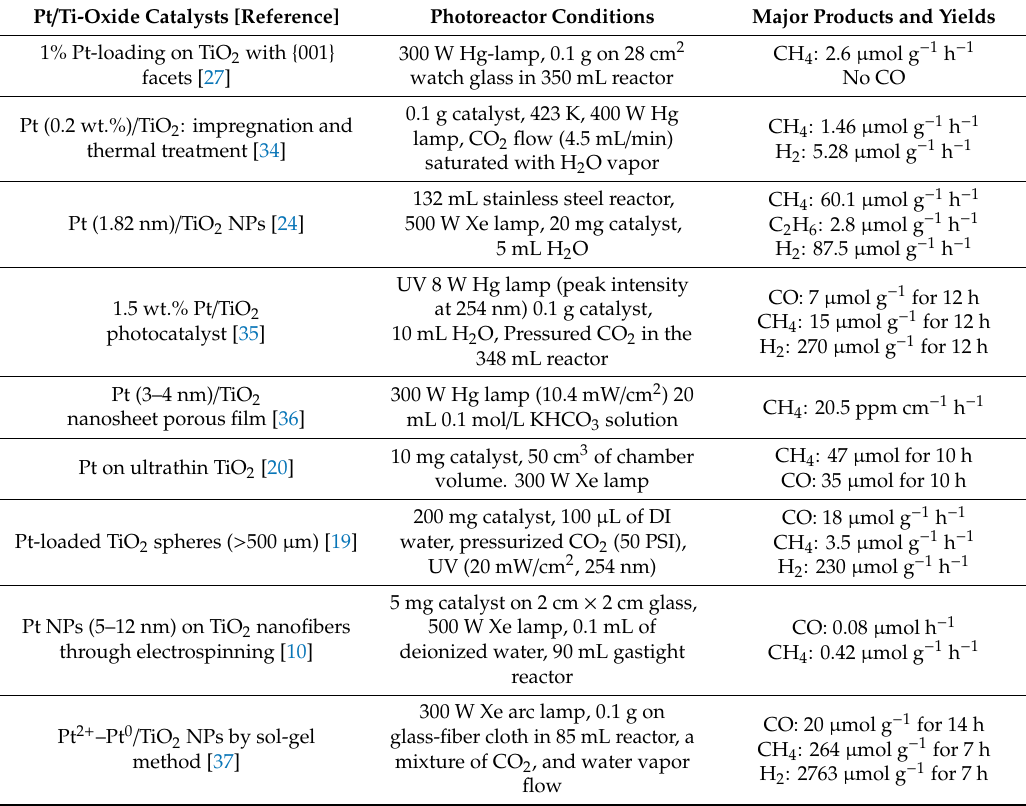
Table 1. Photoreactor conditions and reduction yields for reported Pt / Ti-oxide-based catalysts. Pt / Ti-Oxide Catalysts